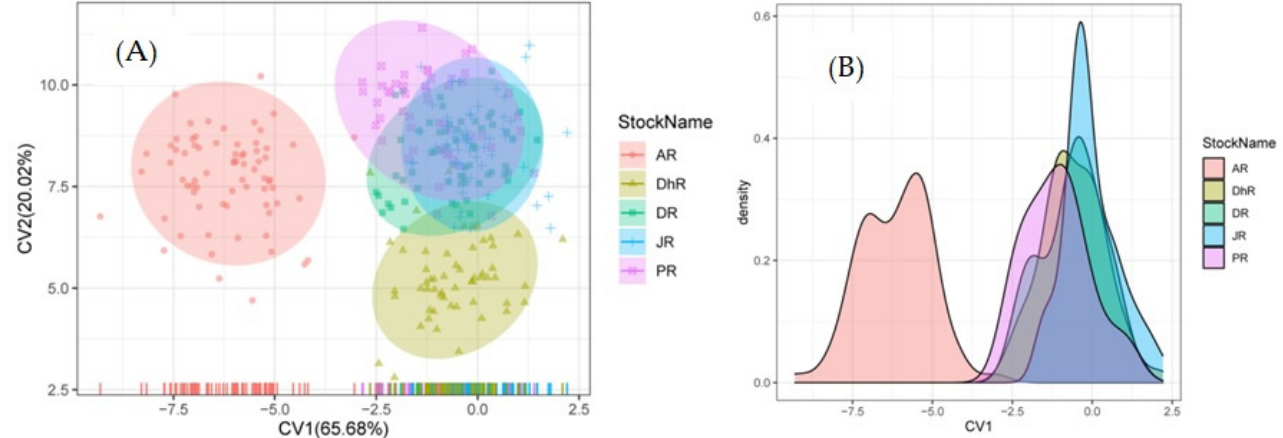
Figure 7. Canonical Variate Analysis (CVA) of truss measurements of Botia dario stocks obtained from the five rivers of Bangladesh. ( A ) Bi-plots of sample centroids of the canonical variates scores are and ( B ) density contributions shown. In the figure, stocks areas are shortened as JR, Jamuna River; AR, Atrai River; DhR, Dhorala River; DR, Danu River, and PR, Padma River. CVA, using original and cross-validation classification, revealed that 89.0% and 85.9% of the individuals, respectively, were classified into their original population groups. The maximum correct classification was observed in the Jamuna River (77.4%), followed by the Jamuna (80.0%), Danu (90.0%), Dhorala (94.6%), and Atrai River (94.6%). In